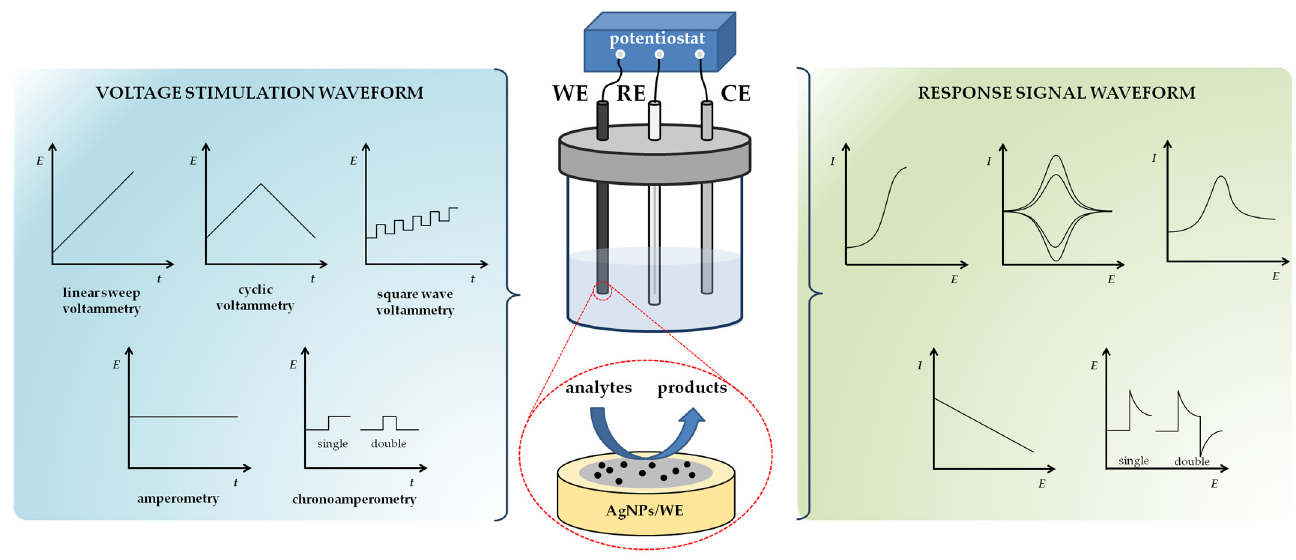
Figure 4. Schematic representation of voltammetric and amperometric techniques used for detection of emerging water pollutants. In the scheme, E stands for potential, I for current, and t for time.